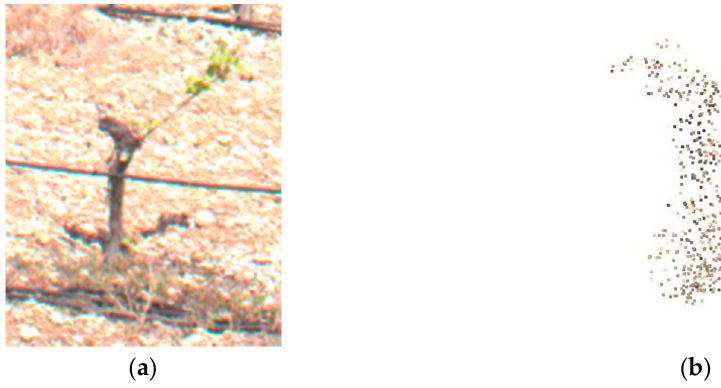
Figure 12. ( a ) Real vine. ( b ) Preprocessed MMS point cloud taken from the same vine.